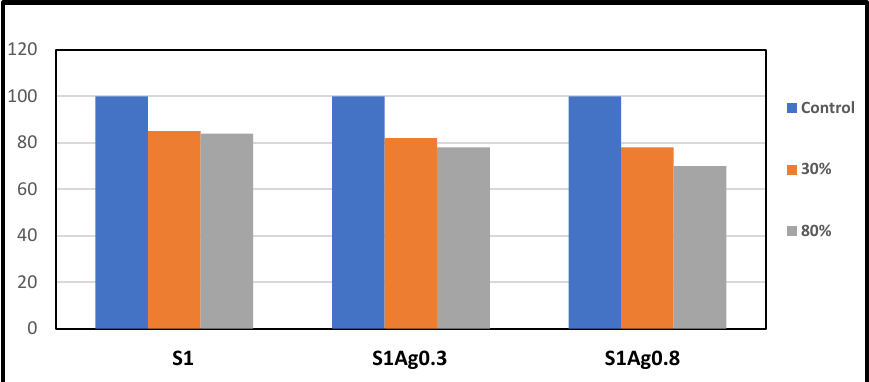
Figure 5. Cytotoxicity tests from MTT assay of the cell viability, detection of the toxicity of S1, S1Ag0.3, and S1Ag0.8. Absorbance was normalized to that of the negative control at each time interval and was considered 100%. The data are presented as the mean ± standard deviation ( n = 5).